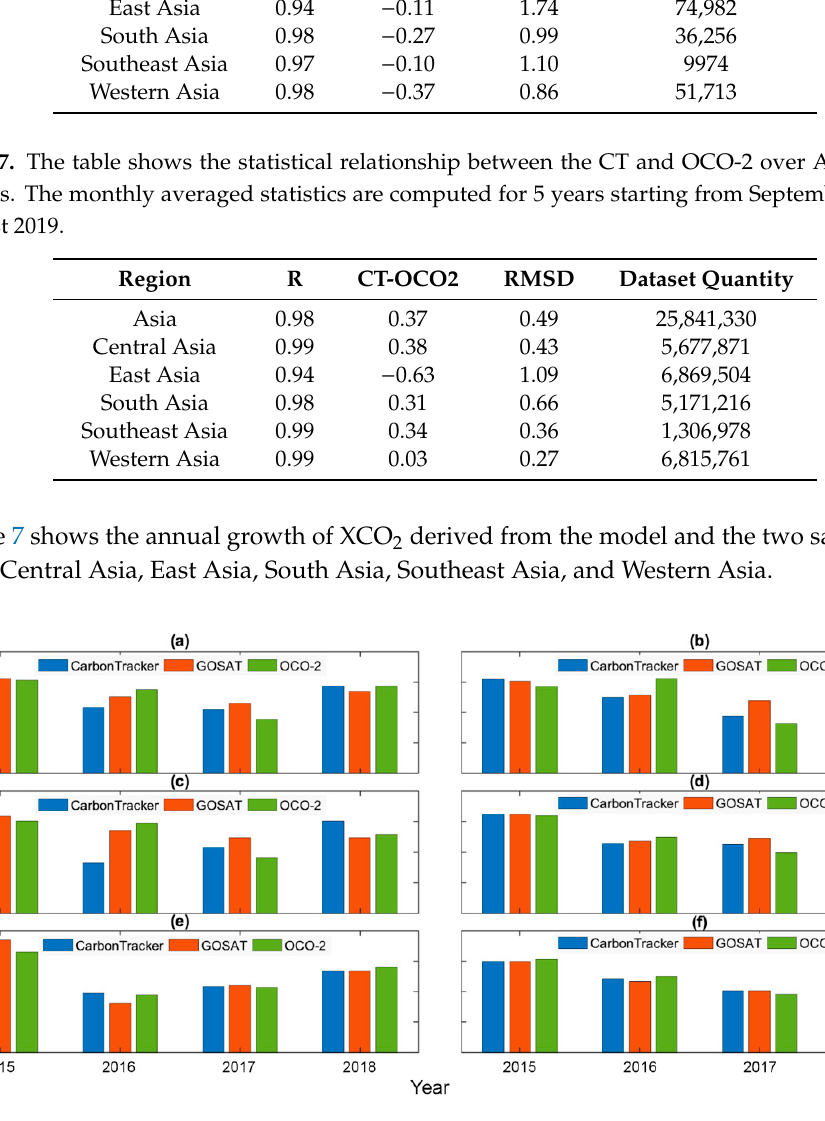
Figure 7. The annual growth rate of XCO 2 concentration for the CT and the satellite datasets over ( a